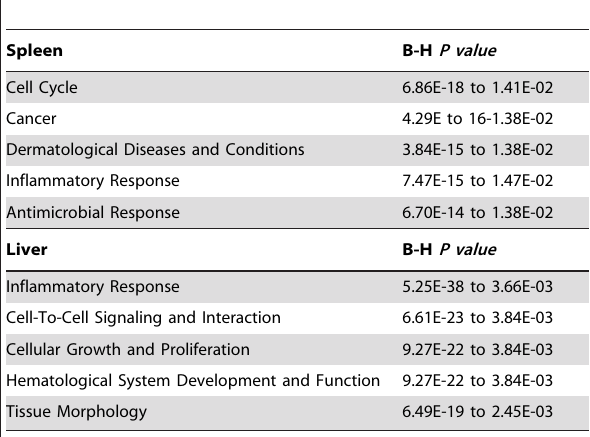
Table 1. Top biological categories determined by IPA.